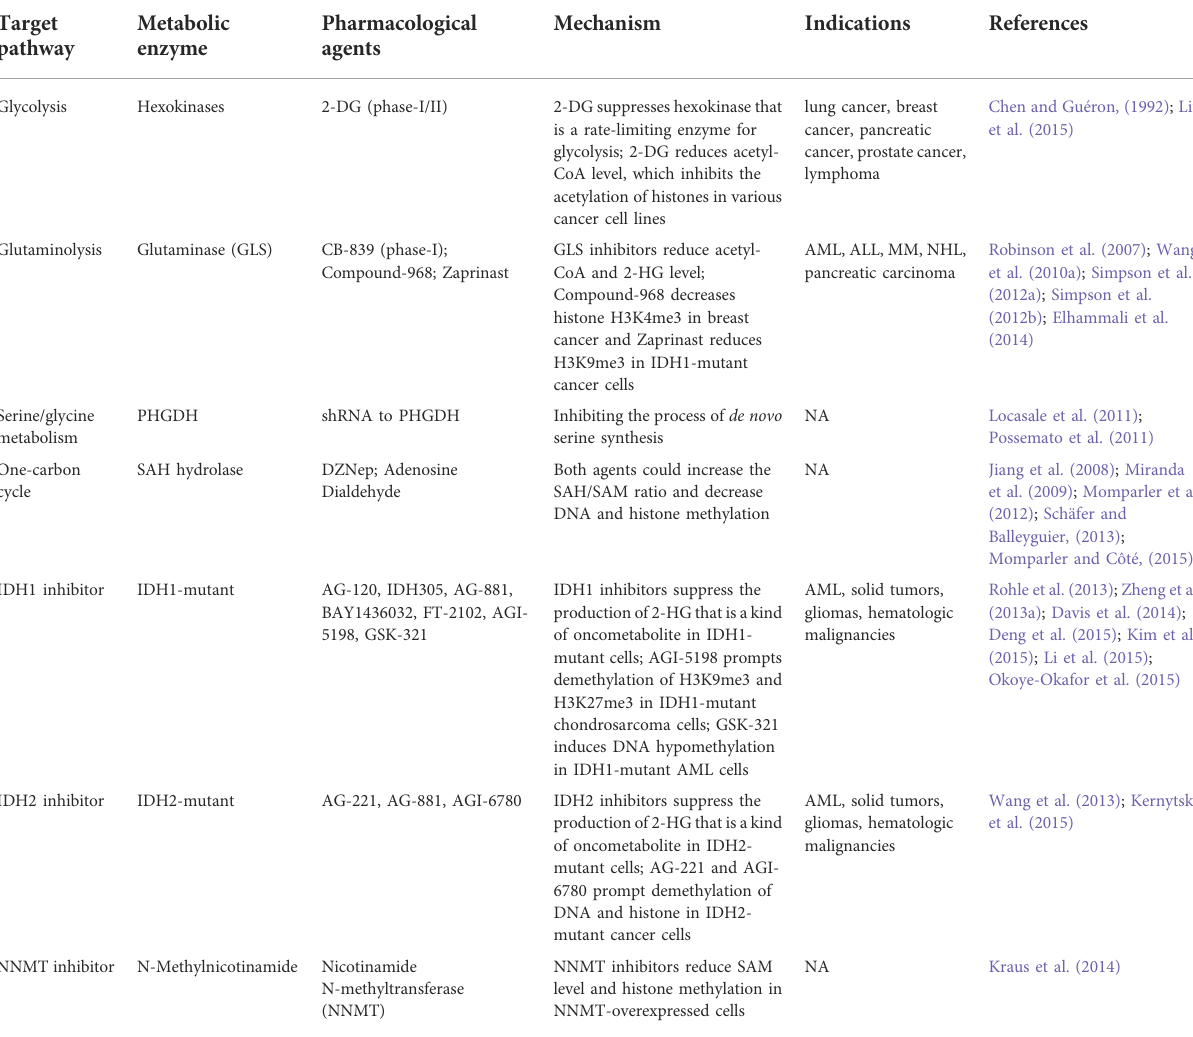
TABLE 4 Reversal of epigenetic dysfunction by targeting